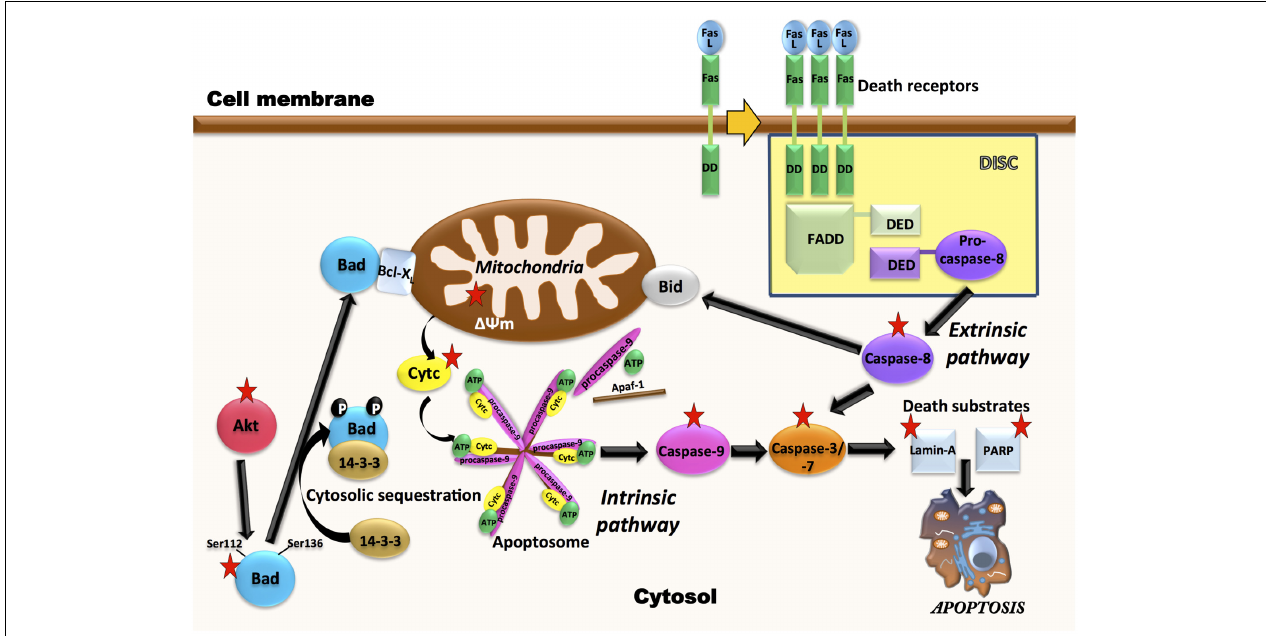
FIGURE 9 | Multiple molecular targets are simultaneously involved in the pro-apoptotic effect of AD0157 on human myeloid leukemia cells. On the one hand, in the control of intrinsic pathway of apoptosis, inhibition of Akt phosphorylation by AD0157 could lead to dephosphorylation of pro-apoptotic Bad, causing a drop in the mitochondrial membrane potential and triggering the release of cytochrome c into the cytosol. This could facilitate the formation of apoptosome, which activates the initiator caspase-9 that would cause an activation of executioner caspases-3/-7, ultimately leading to apoptosis. On the other hand, the effect of AD0157 on the extrinsic pathway of apoptosis is suggested by the increase in the caspase-8 activity, which could then prompt the activation of the effector caspases. In addition, caspase-8 could initiate a mitochondrial amplification loop, mediated by the cleavage of the BH3-only protein Bid. In the scheme, targets of AD0157 are indicated with a red